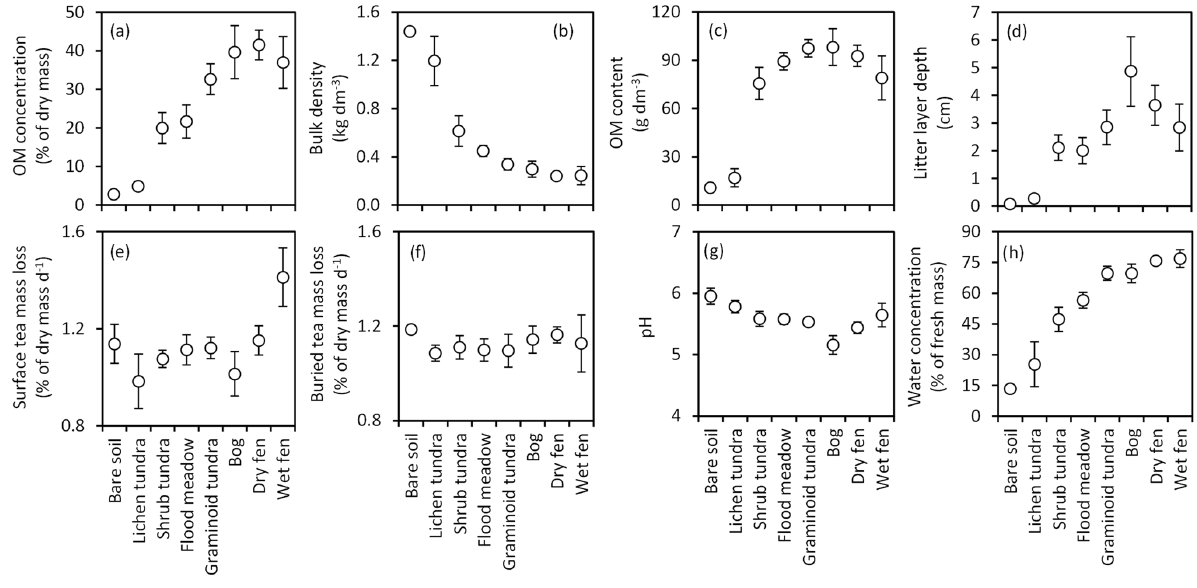
Figure 4. Means ( ± 85% CI) of (a) organic matter (OM) concentration, (b) bulk density and (c) OM content of the top 10cm soil layer; (d) depth of the litter layer (including both vascular and moss plant material); mass loss of tea, (e) placed on the soil surface or (f) buried in the soil at a depth of 5cm; and (g) pH and (h) water concentration of the top 10cm soil layer in the land cover types of the Siberian Arctic tundra at Tiksi (arranged in order of increasing soil water concentration).